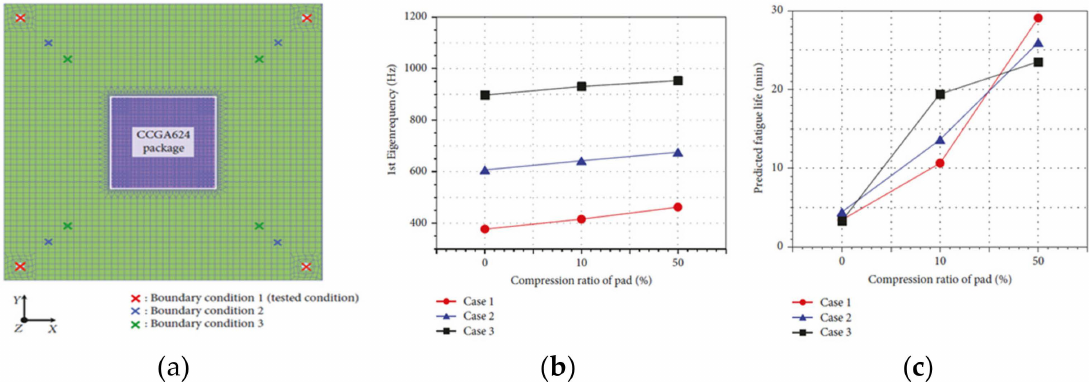
Figure 18. Numerical fatigue life prediction on solder joint [10]. ( a ) Boundary conditions for structural analysis. ( b ) 1st Eigen-frequency of the PCB for the compression ratio of the thermal gap pad in each case. ( c ) Fatigue life on solder joint for CCGA624 package with respect to the fatigue life in each